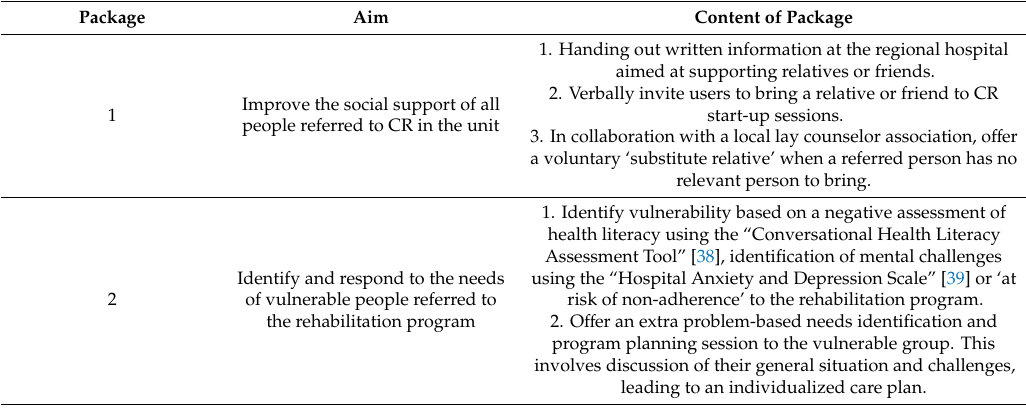
Table 4. Intervention packages developed in the Heart Skills Study in Randers Municipal Rehabilitation Unit